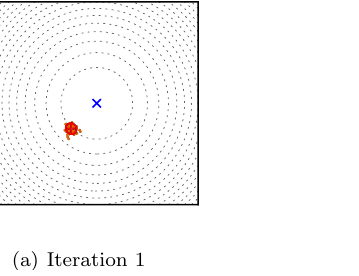
Figure 6. The optimizationproblem of a two-dimensional linear function using the CMA-ES algo- Fig. 2 An illustration of CMA-ES optimization on a two-dimensional linear function f ( x ) = x 2 1 + x 2 2 . The dashed lines are rithm. The orange and gray dots represent the distributions of the child and the parent the contour lines of the function. The optimal solution is in the upper right corner. The orange and gray dots denote the population distribution for the current and the last iteration, respectively. The black cross (’+’) and the black ellipsoid denote the symmetry center and the isodensity line of the distribution for the current iteration, while the gray cross and the gray ellipsoid are for the last iteration.